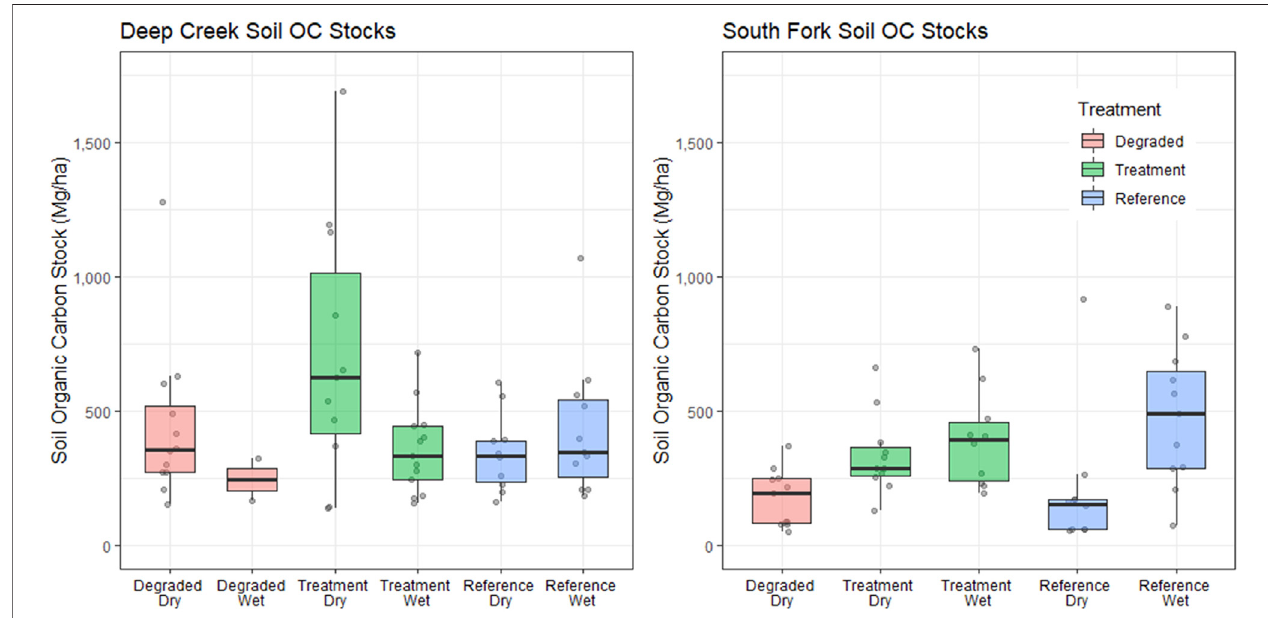
FIGURE6 | Box and whisker plotsof soil organic carbon stock for wet and dry portionsofeach ofthe sixclasses. Line within each box indicates the median value, box ends are the upper and lower quartile, and whiskers are the 10th and 90th percentiles. Data points summarized by each box are also shown. Differences in South Fork McKenzie River organic carbon stocks were analyzed by class only due to a lack of wet samples from the degraded fl oodplain.